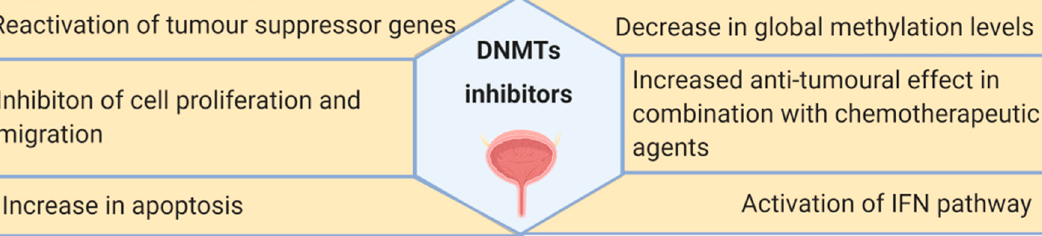
Figure 4. Summary of the main effects of DNMT inhibitors observed in bladder cancer in vitro and in vivo models, as well as in clinical trials.